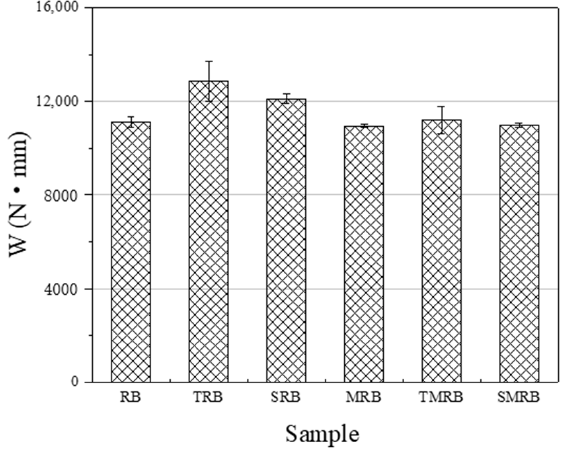
Figure 8. Fracture energy of rubberized bitumen.